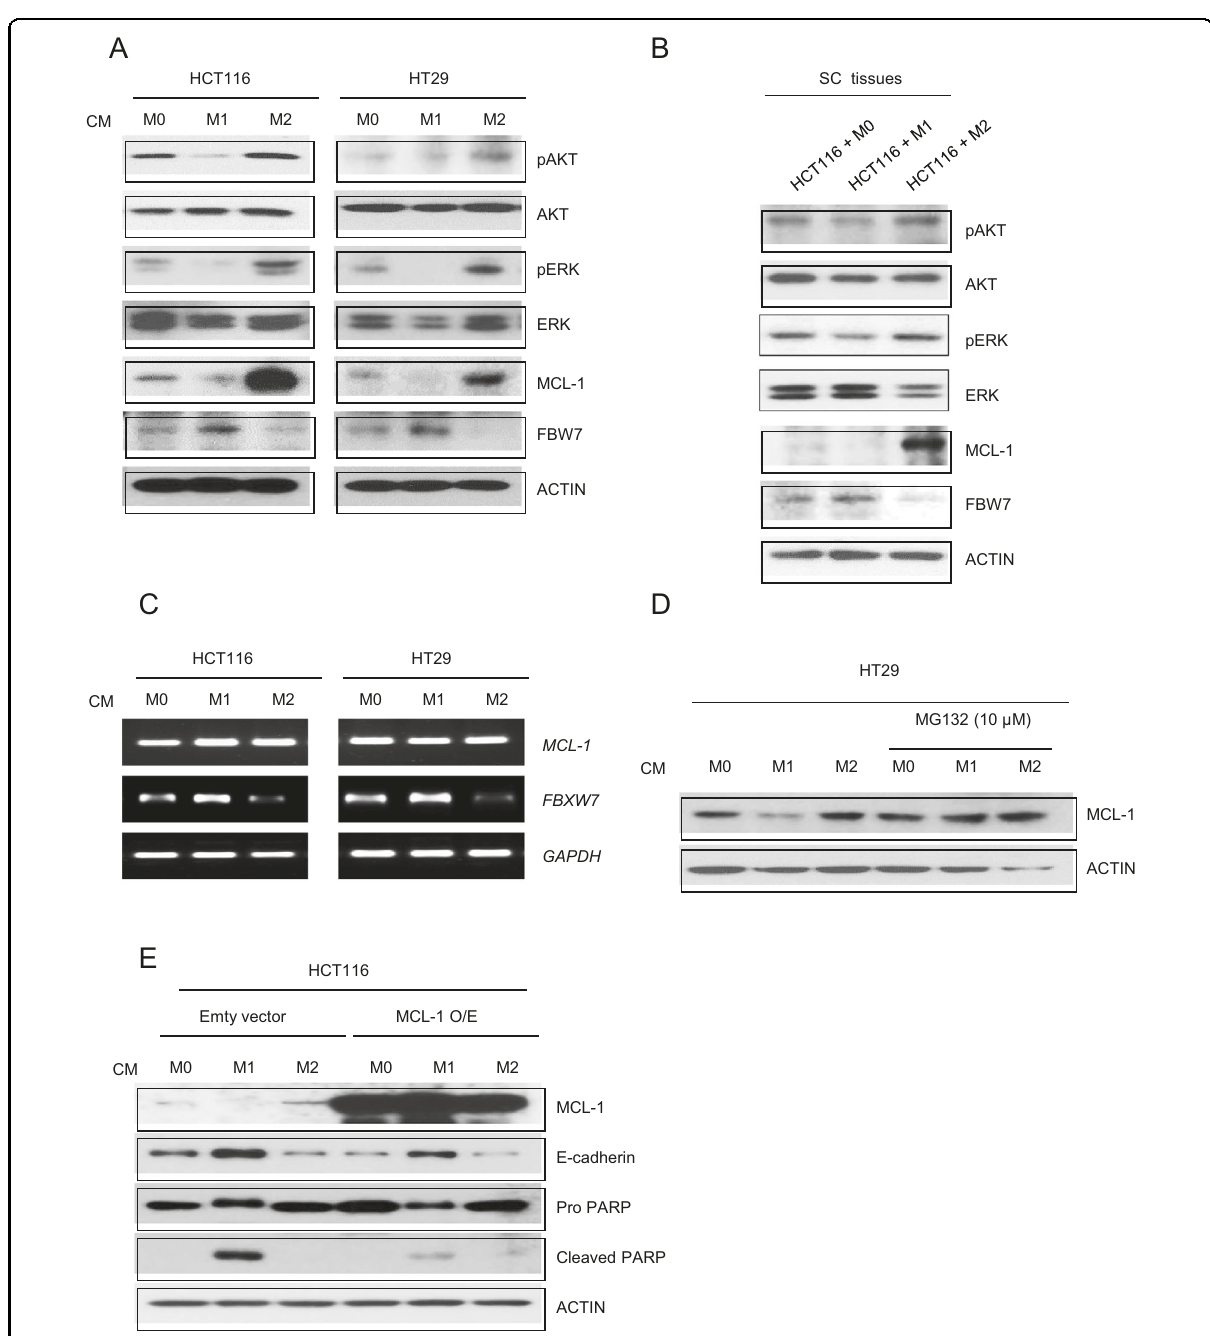
Fig. 4 Opposite effects of M1 macrophage CM and M2 macrophage CM on FBW7-mediated MCL-1 degradation of colon cancer cells. Expression levels of AKT, ERK, MCL-1, and FBW7 in a macrophage CM-treated HCT116 and HT29 cells and in b mouse subcutaneous tissues transplanted with long-term coculture and differentiated M0, M1, and M2 macrophages. c mRNA levels of MCL-1 and FBW7 were evaluated by RT-PCR after macrophage CM treatment for 24h. d HT29 cells were exposed to MG132 for 1h and incubated with macrophage CM for 24h. e HCT116 cells were transfected with either empty vector or MCL-1 expression vector for 24h, followed by incubation with macrophage CM for another 24h. Actin was used as a loading